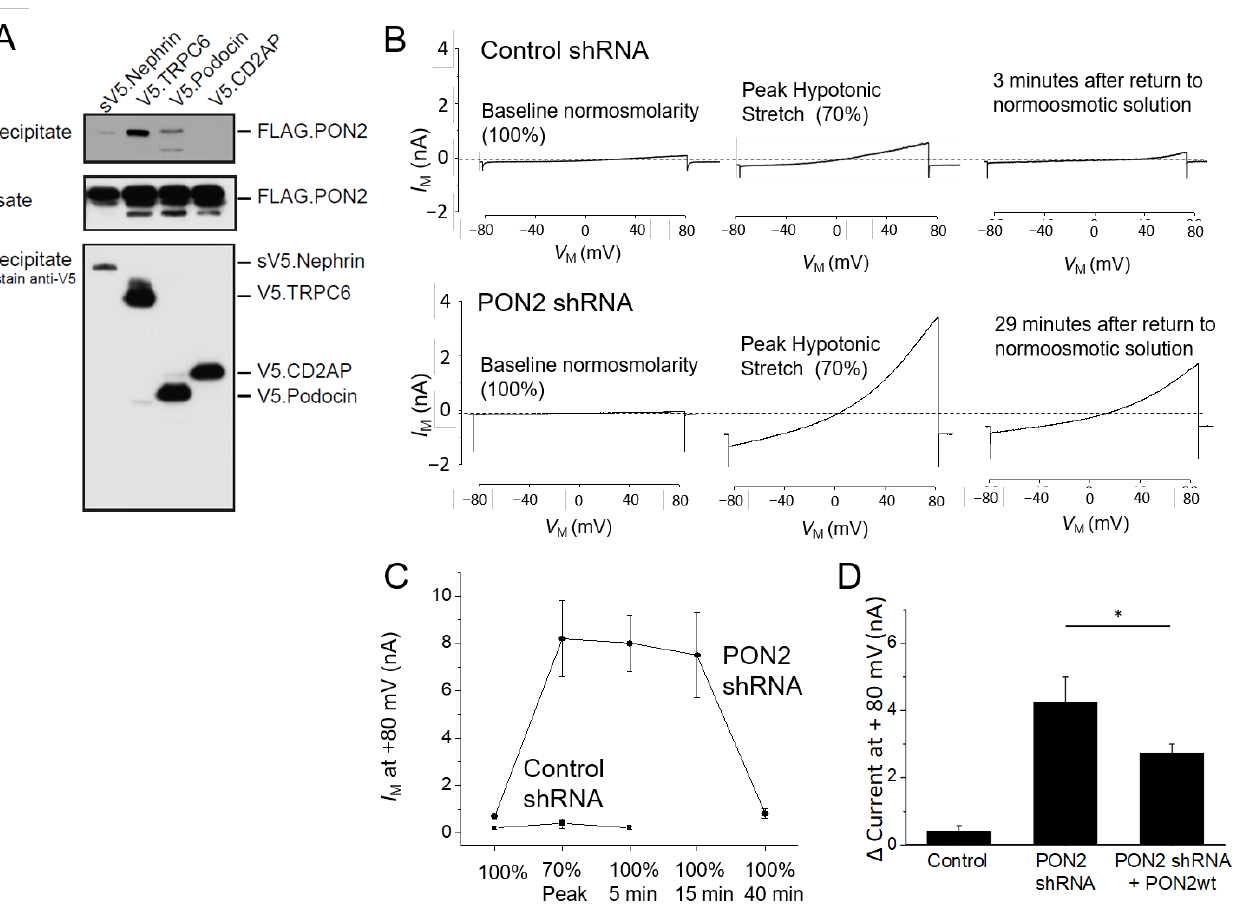
Figure 5. TRPC6 conductance is regulated by PON2. ( A ) Immunoprecipitation of FLAG-tagged PON2 and V5-tagged slit diaphragm proteins reveals interaction of PON2 and TRPC6, Podocin, and Nephrin and no interaction with CD2AP. ( B ) Representative recordings of whole cell voltage clamp experiments using PON2-proficient and -deficient murine podocytes. TRPC6 currents in response to membrane stretch after hypotonic stimulation (70%) are largely increased in PON2-deficient podocytes. ( C ) Currents at +80 mV during whole cell recordings including medium change from 100% tonicity to 70% tonicity and back. In PON2-deficient podocytes currents stay active for 40 min, while control cells recover after 5 min. ( D ) Enhanced TRPC6 conductance of PON2-deficient podocytes is reduced by re-expression of PON2 wildtype (* p < 0.05) (control mean 0.39 nA, SD 0.16; PON2 shRNA mean 4.26 nA, SD 0.73; PON2 shRNA + PON2 wt 2.73 nA, SD 0.26).